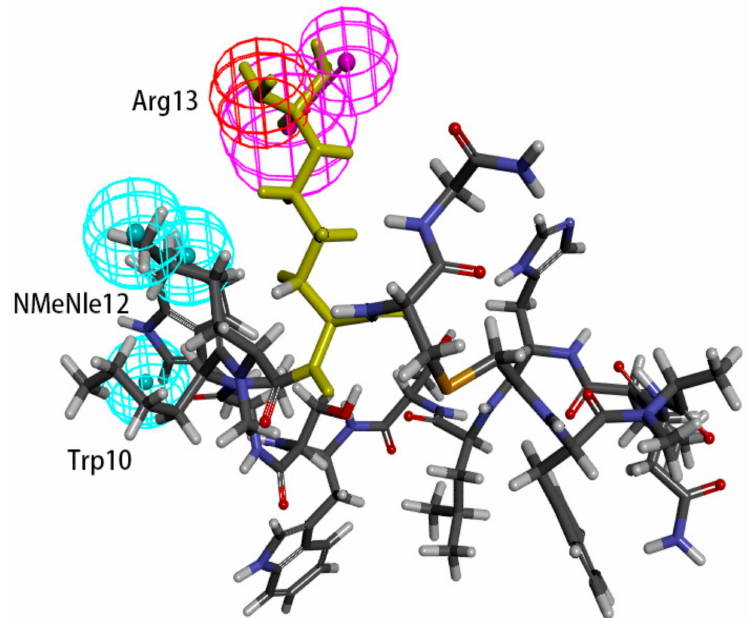
Figure 13. Superposition between Hypo 1B and peptide-57. As the figure shows, the positive ionizable point is red, the hydrophobic point is blue, and the hydrogen bond donor is purple. The yellow amino acid is